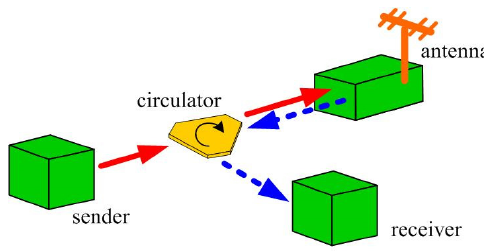
Figure 1. Circulator in the communication systems.